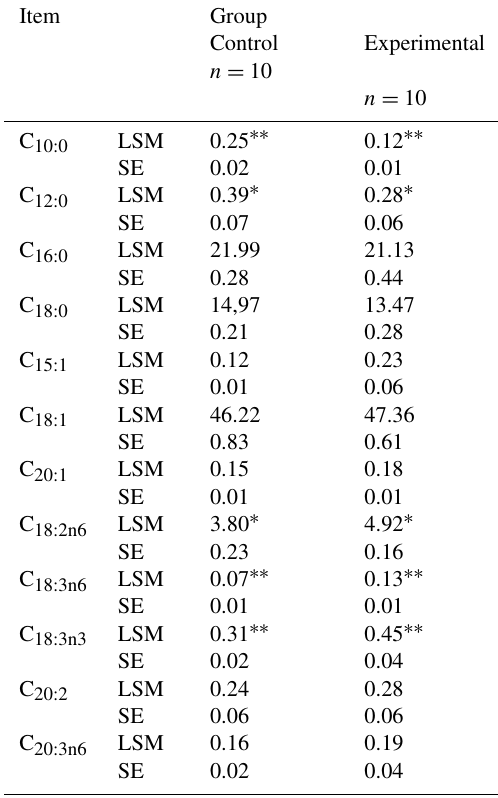
Table 6. Percentage of fatty acids identified in the lipid fraction of muscle tissue (%). Item